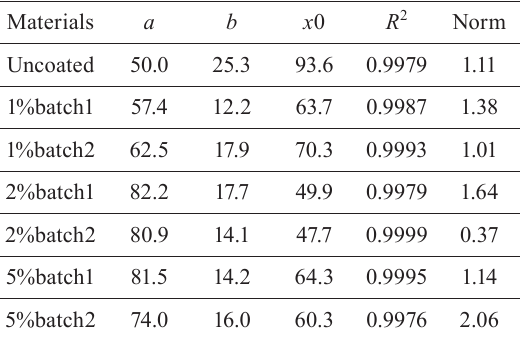
Table 1 Non-linear least squares estimated parameters of the 3-parameter fitting of the relative de- agglomeration versus flow rate profile for uncoated and 1 %, 2 % and 5 % (w/w) magne - sium stearate (MgSt) coated salbutamol sulphate (SS). The maximum relative de-agglomeration, difference in flow rate between 75 % and 25 % of the relative de-agglomeration and air flow to achieve 50 % of the maximum relative